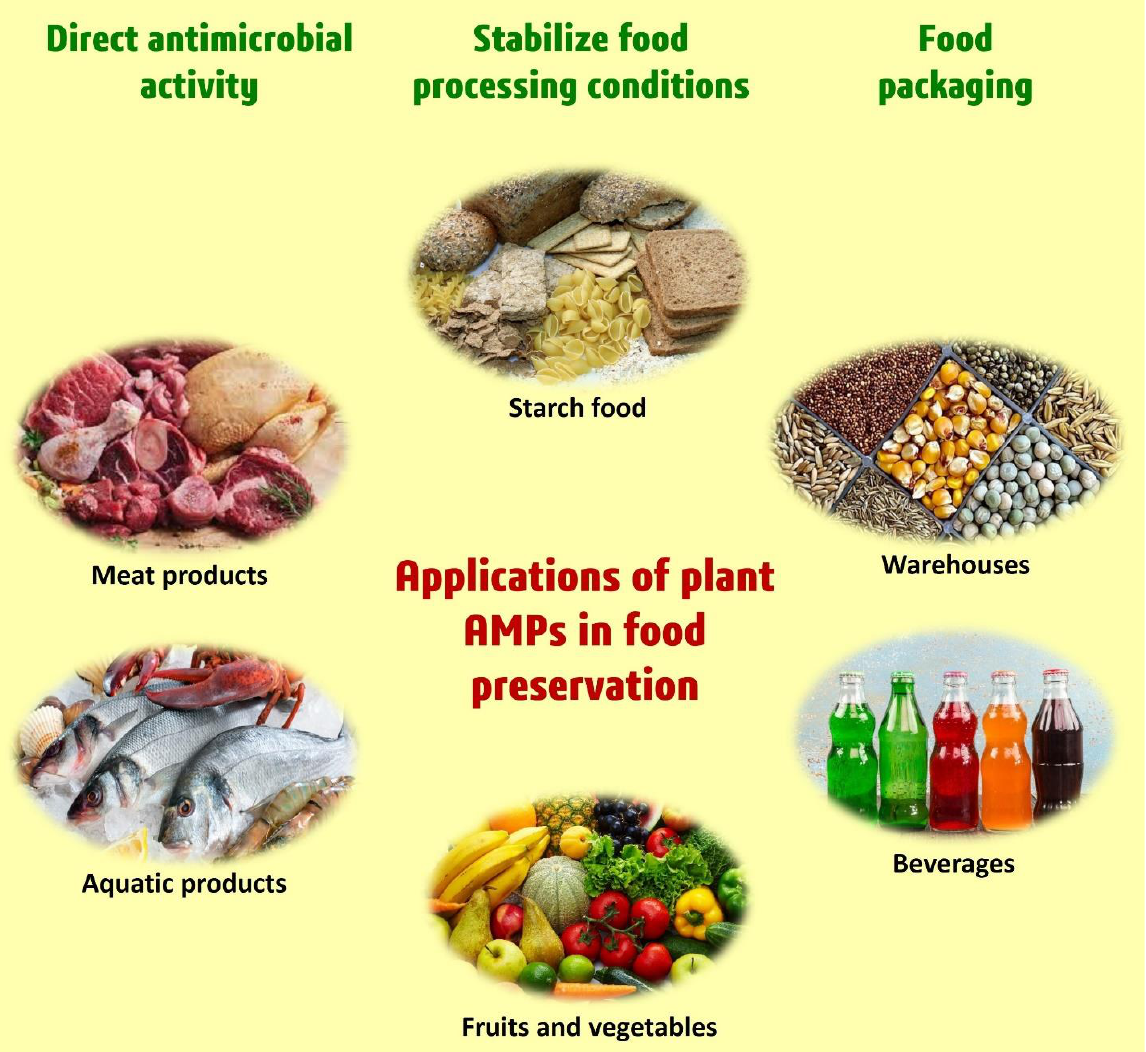
Figure 7. Different applications of plant AMPs in raw, processed, and liquid food.